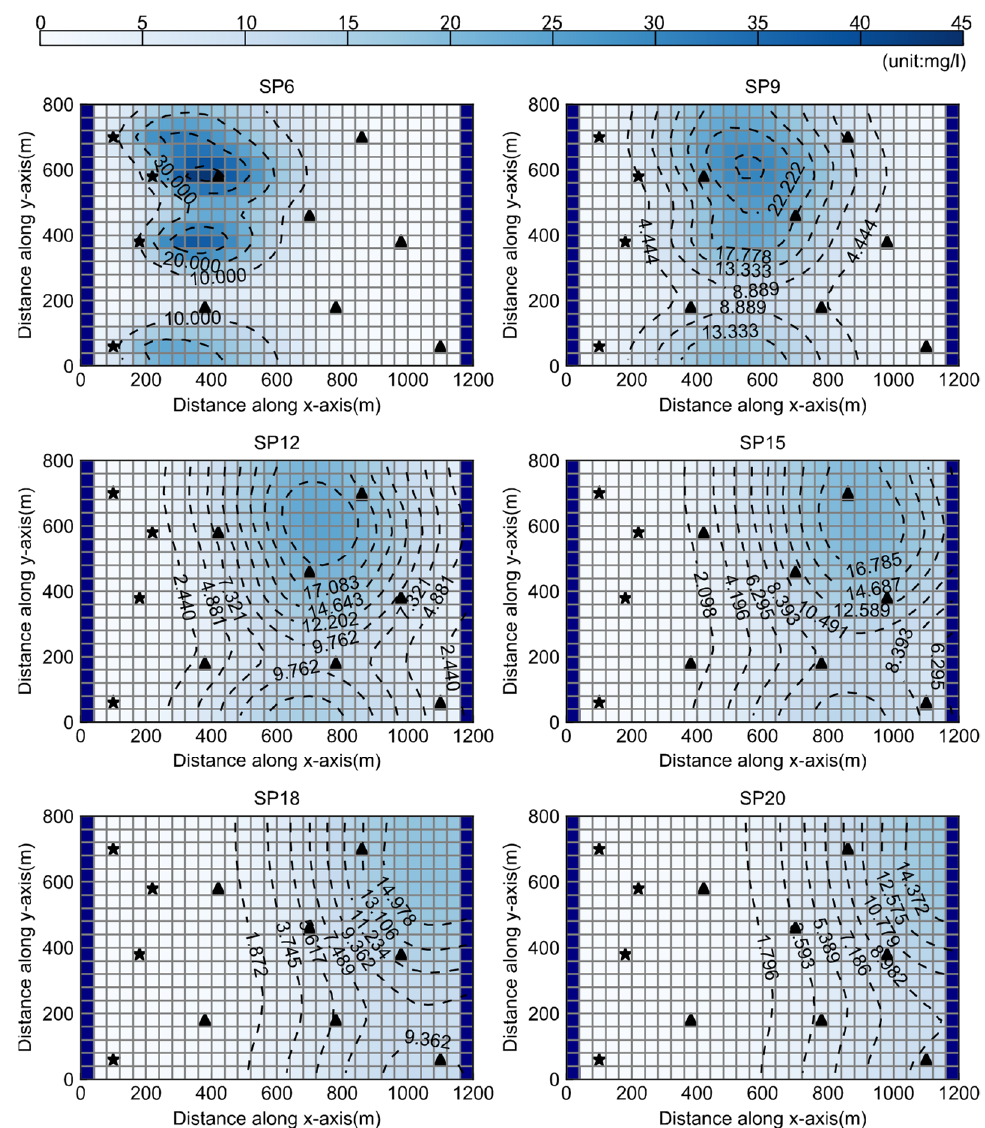
Figure 8. Contaminant plume distributions at SP6, SP9, SP12, SP15, SP18, and SP20.